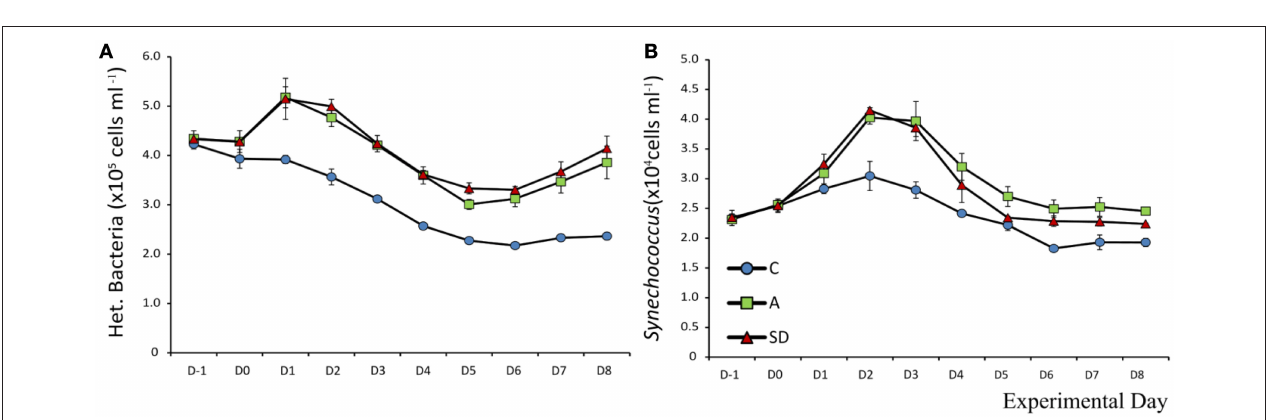
FIGURE 9 | Abundance of (A) heterotrophic bacteria and (B) Synechococcus sp. in each